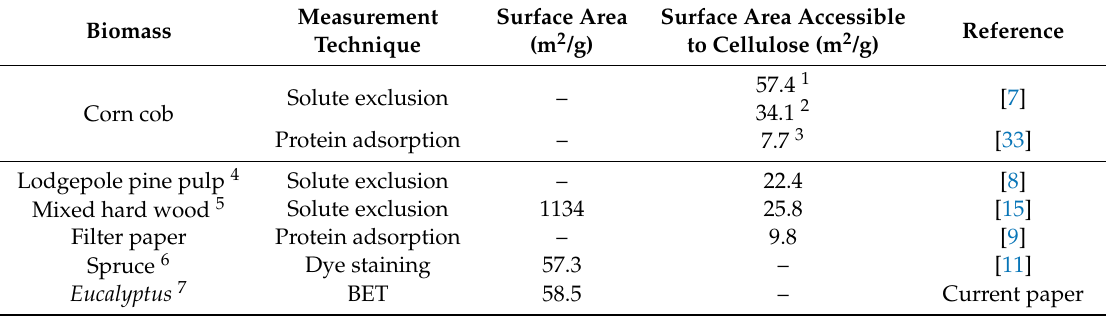
Table 3. Comparison of the BET results with those that were determined by non-drying measurement